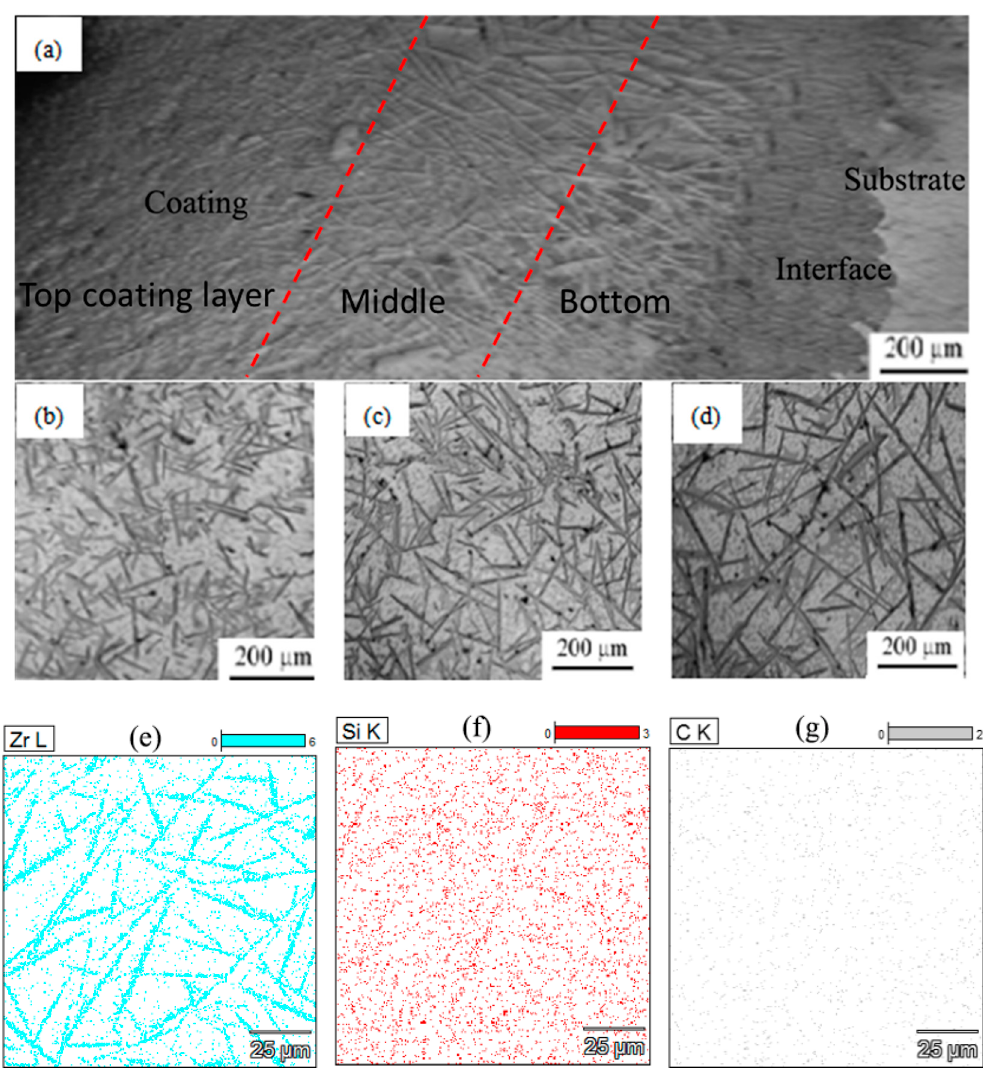
Figure 6. The micro-structure of laser cladding composite coating ( a ) Overall morphology; ( b ) Top; ( c ) Middle; ( d ) Bottom. The element distribution of ( e ) Zr, ( f ) Si, and ( g ) C.